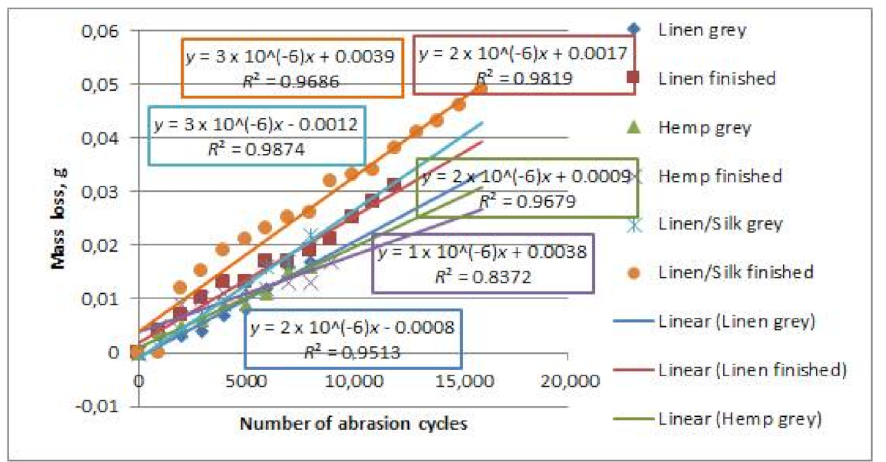
Figure 13. Dependencies of mass loss on the number of abrasion cycles of flax, hemp and flax/silk woven